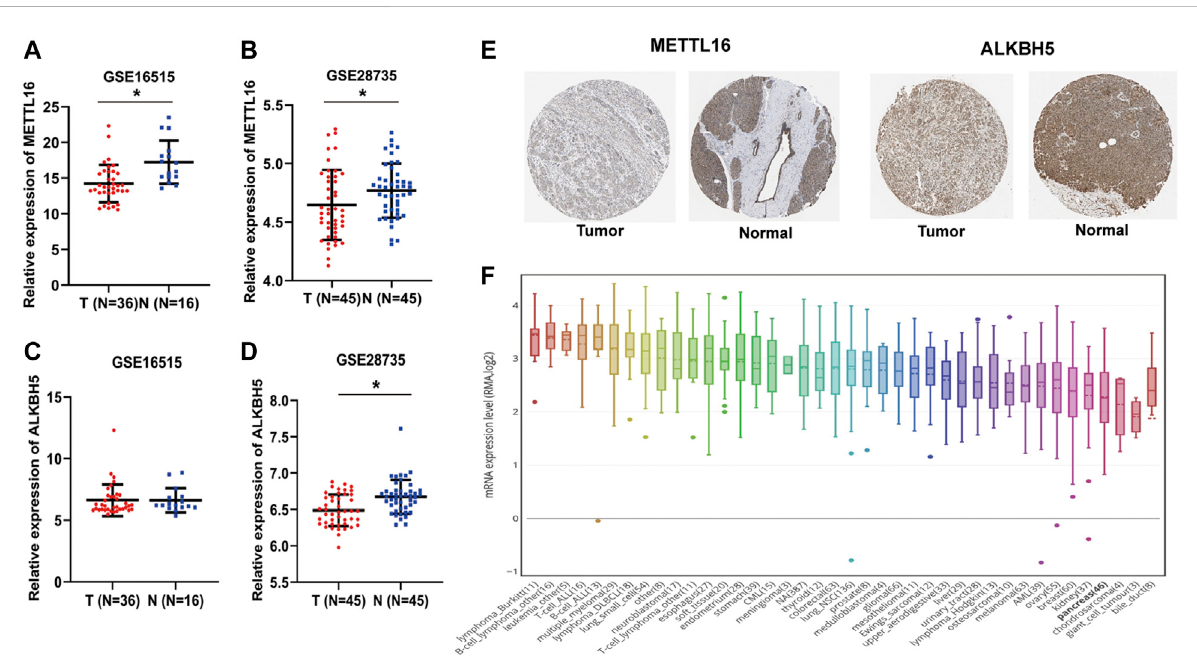
FIGURE 2 Under-expressionofMETTL16and ALKBH5 inPDA. (A,B) Differential METTL16 expressionbetweenPDA andnormaltissues intheGSE16515 (A) and GSE28735 (B) datasets (mean ± SD). (C,D) Differential ALKBH5 expression between PDA and normal tissues in the GSE16515 (C) and GSE28735 (D) datasets (mean ± SD). (E) Immunohistochemistry staining of METTL16 protein in normal pancreatic tissues and PDA in the